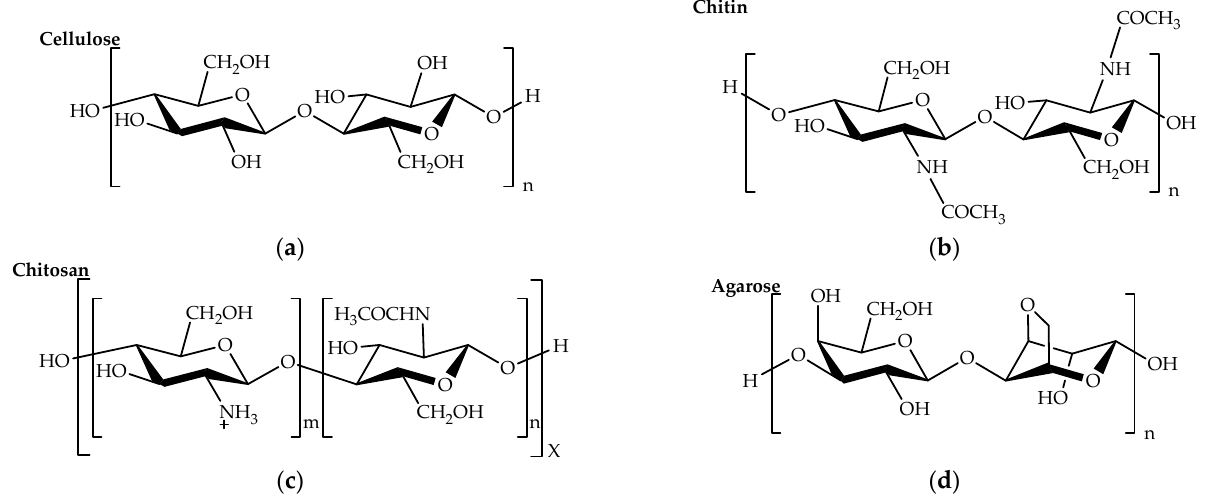
Figure 4. Chemical structures of ( a ) cellulose, ( b ) chitin, ( c ) chitosan, and ( d ) agarose. 3. Types of QACs for Compatibilization of Polymer Blends and Polymer Composites